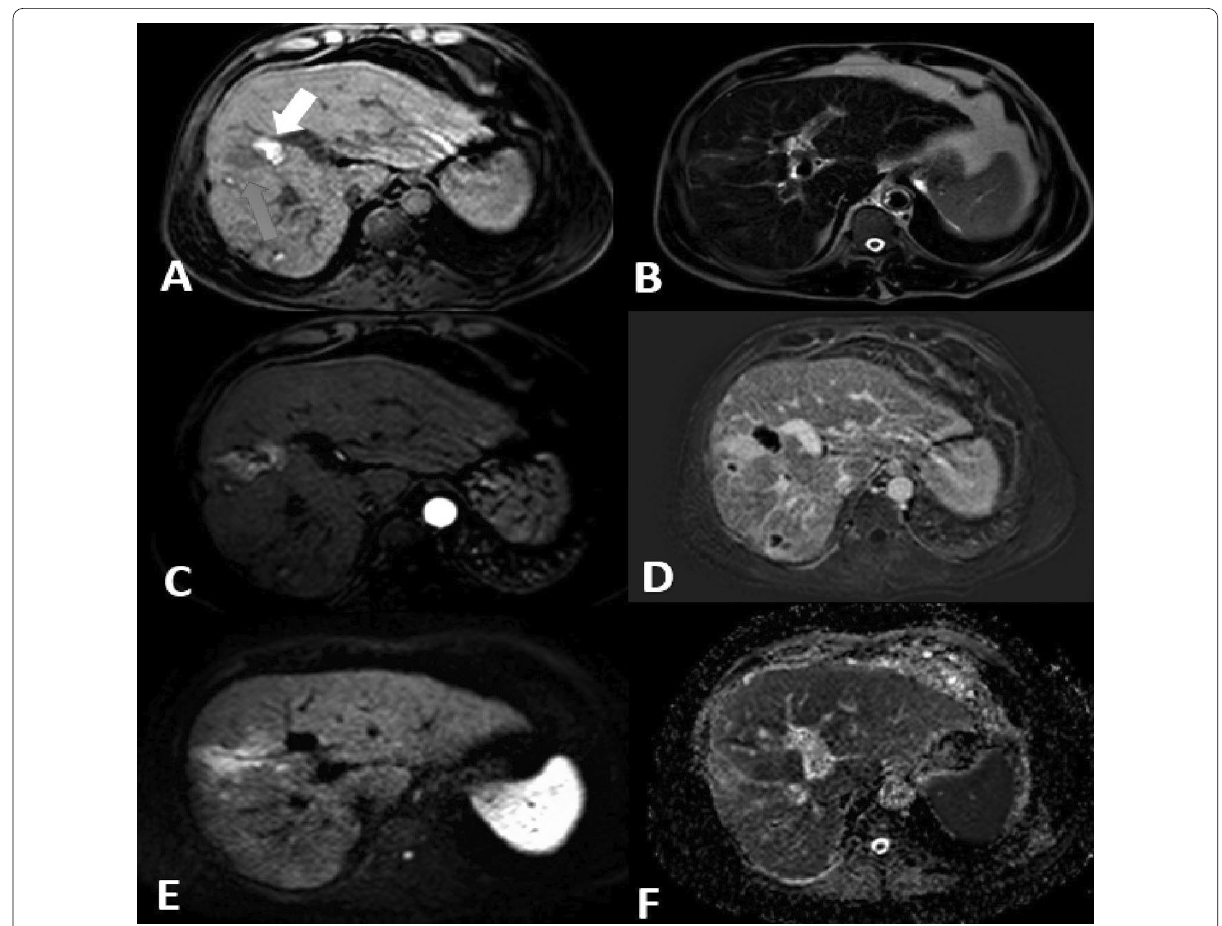
Fig. 5 A 49‑years‑old male patient with cirrhosis having RF ablation for right lobe focal lesion, Dynamic MRI was done with subtraction technique 1 month after RF ablation: a axial T1 showing bright signal of the ablated Lesion (yellow arrow) and hypointense signal of the ablation track (red arrow), b axial T2WI showing bright signal of the ablation lesion and track course, c axial T1WI post contrast showing bright signal of the Lesion as well as the Track, d subtraction MRI confirmed tumoral enhancement along the track course with no enhancement in the ablated lesion increased degree of confidence, in spite that e , f DWI and ADC MAP diffusion appeared restricted in both track and lesion as